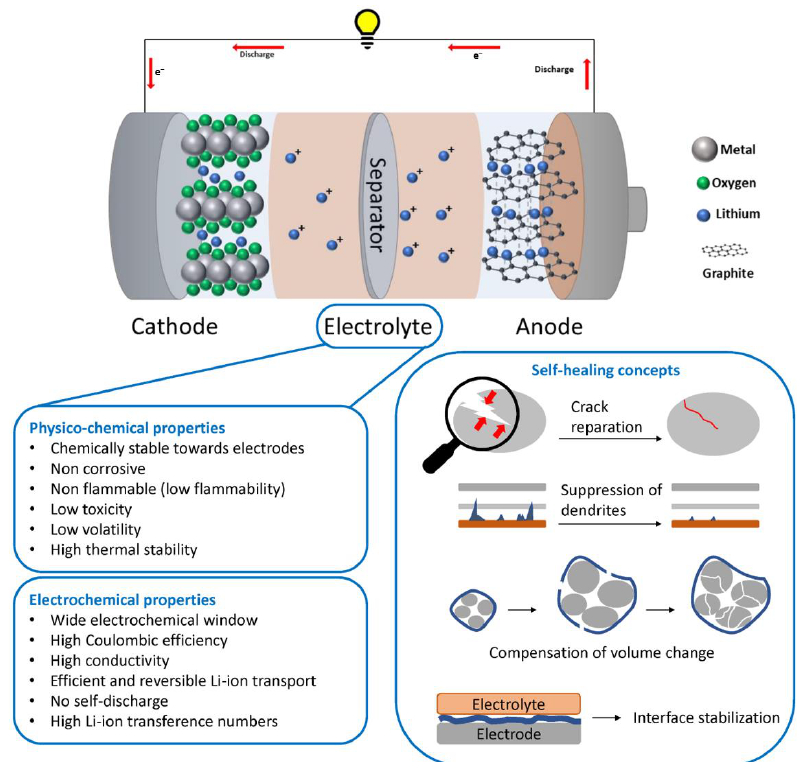
Figure 2. Schematic illustration of a Li-ion battery. The requirements of electrolytes in lithium-based batteries ( left ) and the different roles of self-healing polymers in lithium batteries ( right ).